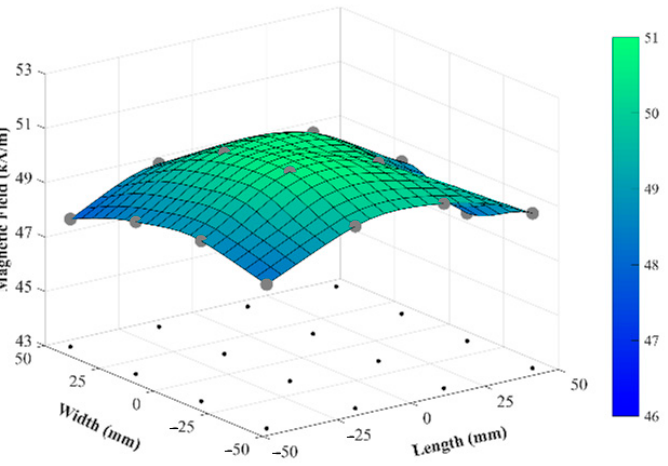
Figure A2. Magnetic field intensity evaluated in the electromagnet gap section. Grey points are the measured data; black points are the measurement position in the airgap; the color surface is the interpolated three-dimensional surface to guide the eye.